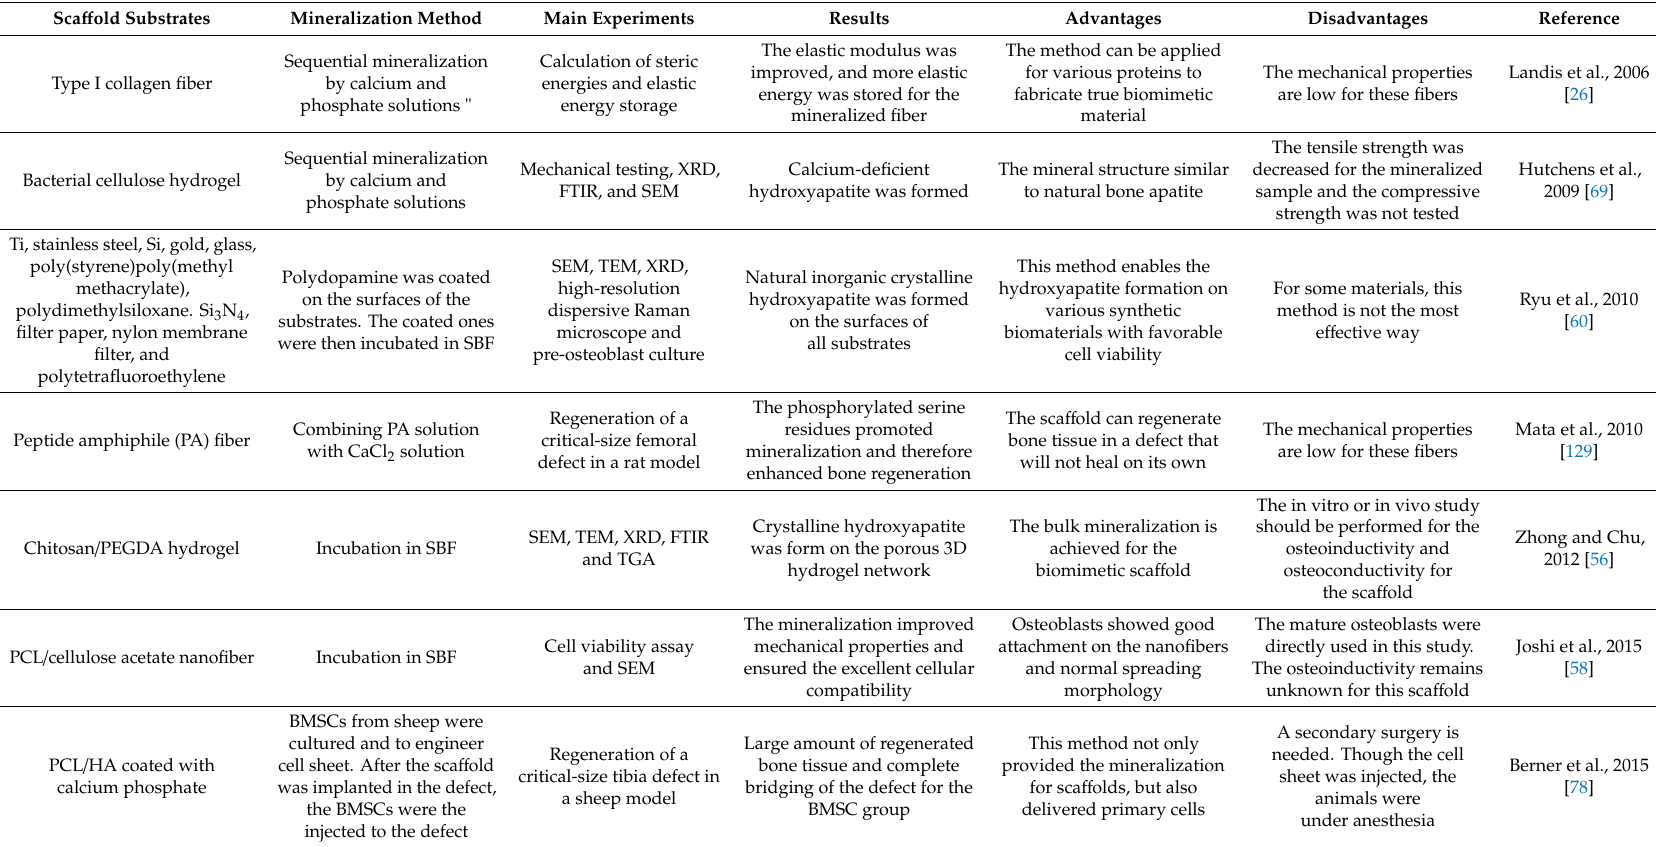
Table 1. Representative studies using mineralization approaches for bone